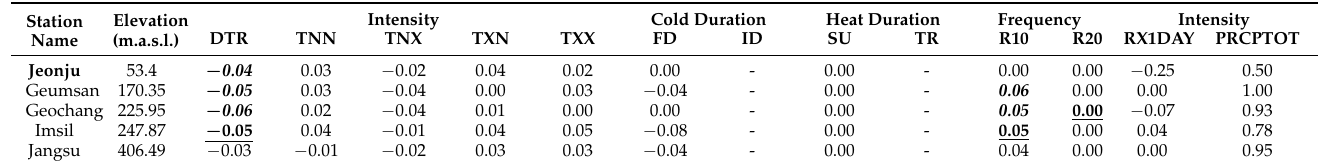
Table A10. Trend magnitudes for the month of April in the UGRB for 33 years (1988–2020).